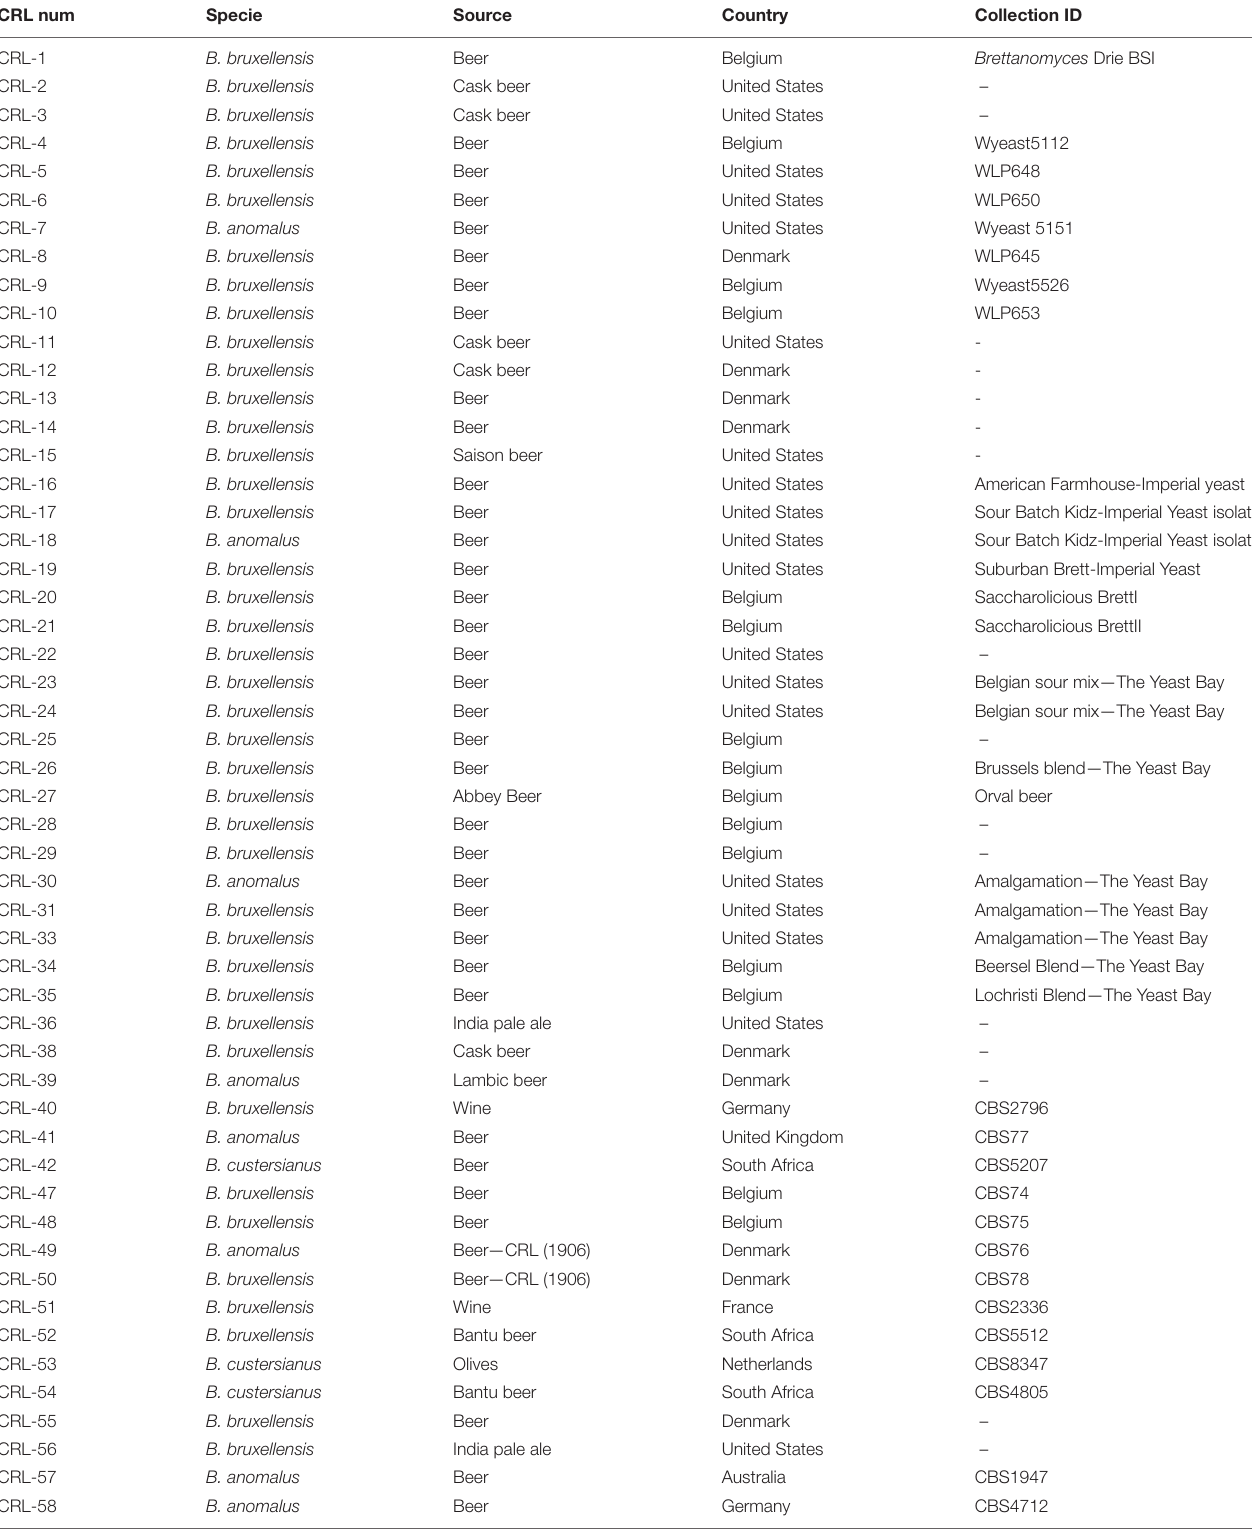
TABLE 1 | List of Brettanomyces strains included in the